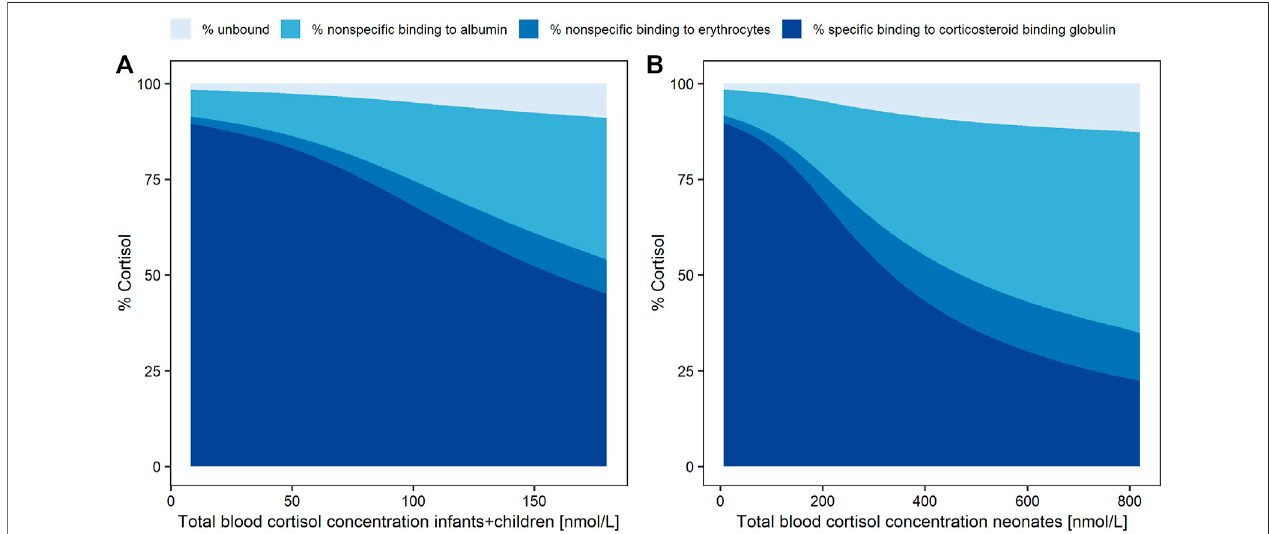
FIGURE3| Simulatedcortisolconcentrationfractions(%)asunbound(paleblue),withnonspeci fi clinearbindingtoalbumin(lightblue),nonspeci fi clinearbindingto red blood cells (middle blue) or speci fi c nonlinear binding (dark blue) to corticosteroid binding globulin, over total whole blood (dried blood spot) concentration (LLOQ = 1.8 nmol/L to Cmax) in infants and children (A) and neonates (B)